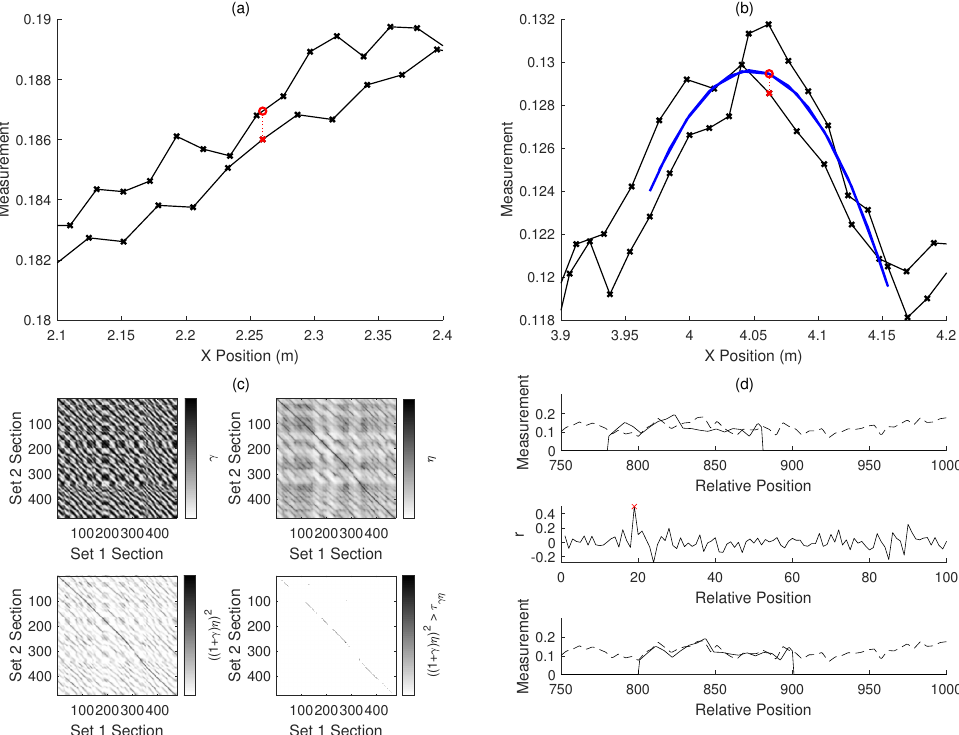
Figure 5. Illustrations of methods of taking information from the measurements of the spatially varying acoustic property: the information is used in the pose-graph optimization to improve the robot trajectory estimate. ( a ) The function of the linear fit method: the two sets of poses and measurements (black crosses) should be aligned. The measurement at the pose in red (at 2.260 m) is predicted to be at the value of the red circle on the line between the two neighbouring points (at 2.255 m and 2.276 m). ( b ) The function of the quadratic fit method: the two sets of poses and measurements (black crosses) should be aligned. The measurement at the pose in red (at 4.062 m) is predicted to be at the value of the red circle on the quadratic fit of the nearby points (shown in blue). ( c ) An illustration of the cross-correlation method: an example of the matching parameters used to find correspondences in the two sets of data split into the labelled sections. γ is the cross-correlation coefficient between the sections, η is the inverse of the sum of squared error between the sections, and (( 1 + γ ) η ) 2 is the parameter used to determine matches between sections by comparison to a threshold τ γη . ( d ) An illustration of the phase-correlation method used to find the offset between the sections of the signals in two sets of measurements: the two misaligned sections ( s 1 and s 2 ) are shown in the first plot. The second plot shows the cross-power function r , where the position of the largest value should correspond to the position shift which best aligns the two sections. The aligned sections are shown in the third